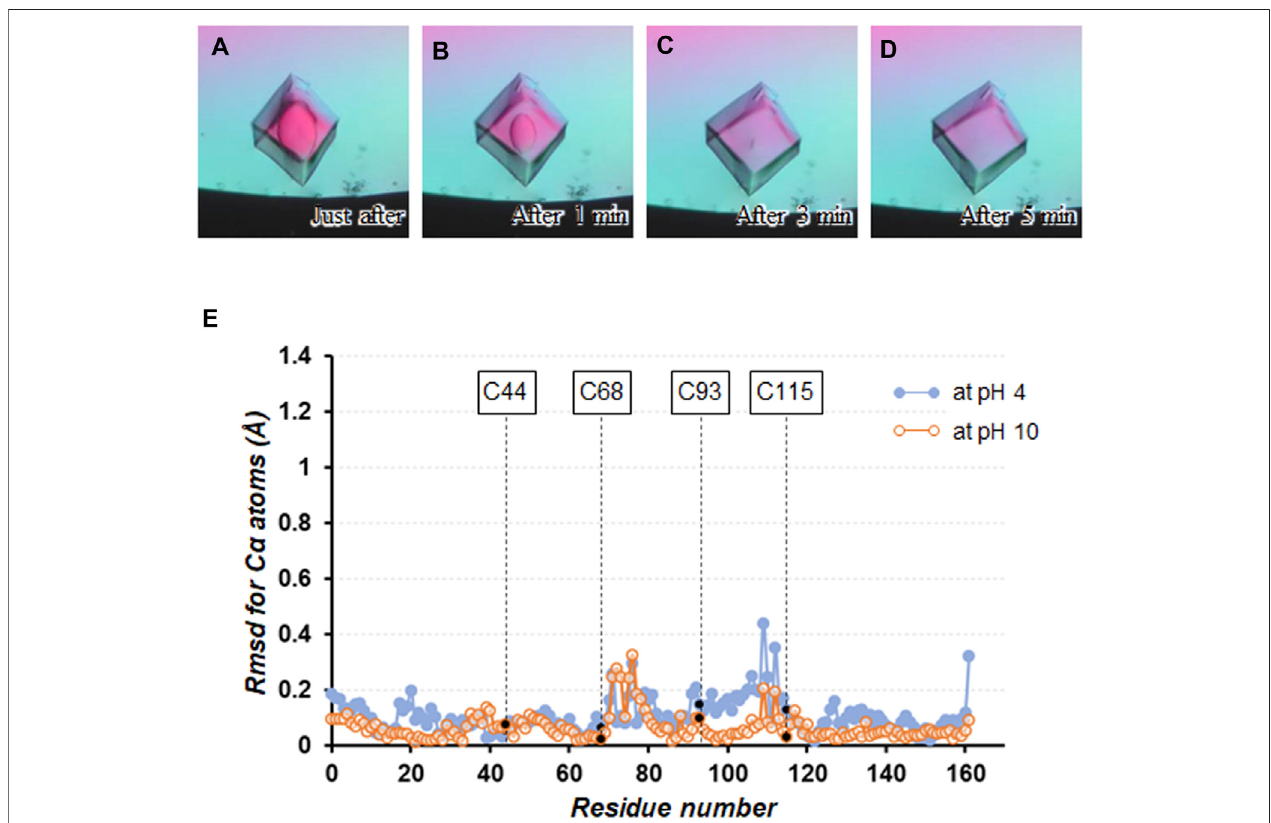
FIGURE3| Soaking experiment usingaprecipitant-free solutionwithpH3. Crystalimages (A) justafter soaking, (B) after 1 min, (C) after 3 min, and (D) after5 min are shown. (E) Plot of the rmsd values for C α atoms between the structures at pH4 and 10 with respect to that at pH7.